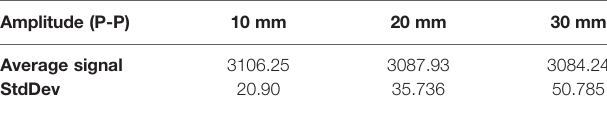
TABLE 1 | Average and standard deviation of signals according to the amplitude of the motion phantom by magnets inside the phantom. Amplitude (P-P) 10 mm 20 mm 30 mm Average signal